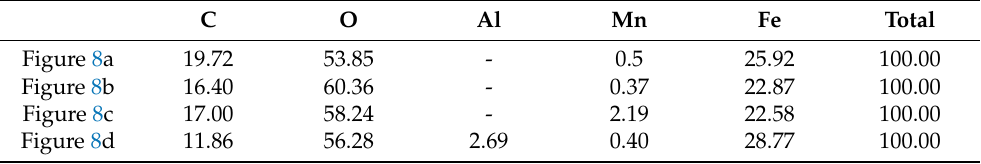
Table 1. Energy-spectrum analysis results of inclusions at four crack sources (at.%).